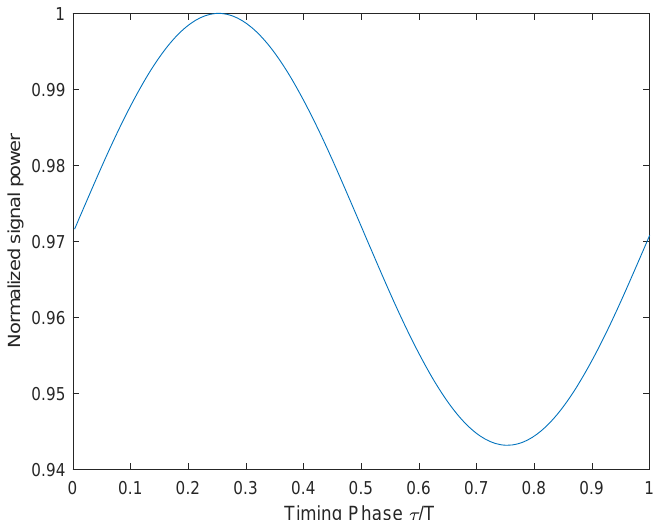
Figure 6. Signal energy of one phase shifting